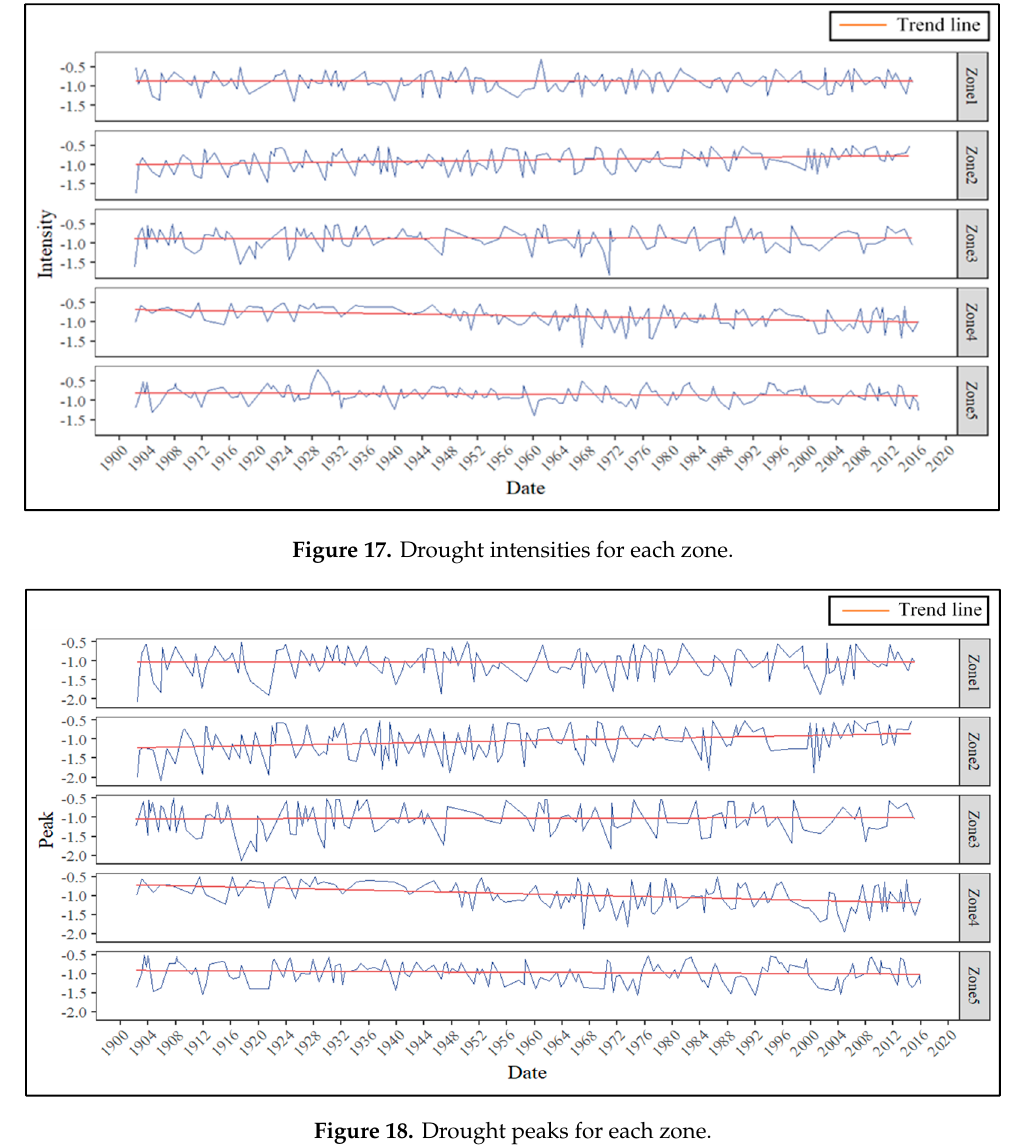
Figure 18. Drought peaks for each zone.